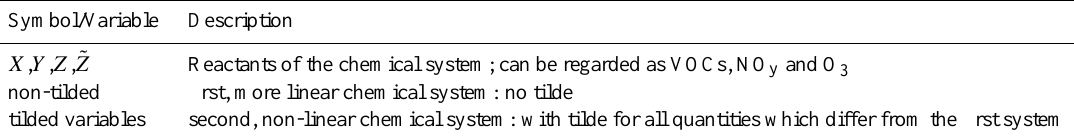
Table 1. Overview on